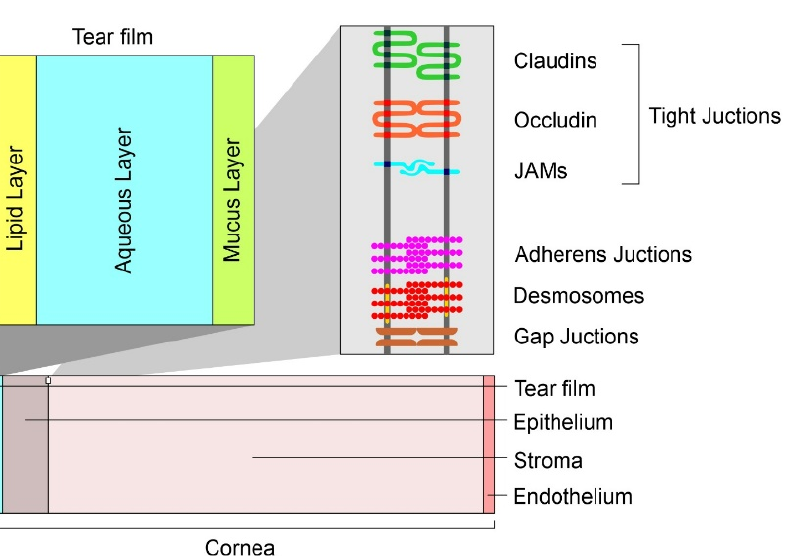
Figure 1. Cross-section of corneal tissues: barriers to drug penetration after topical